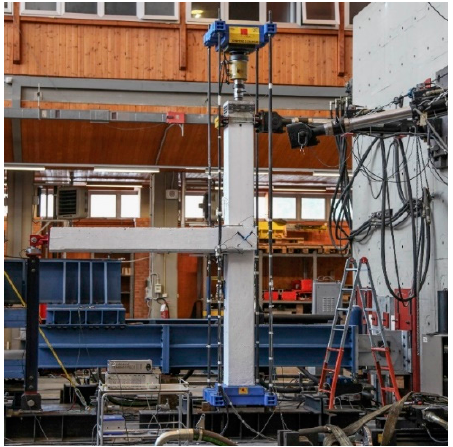
Figure 7. Test apparatus with specimen TS2.